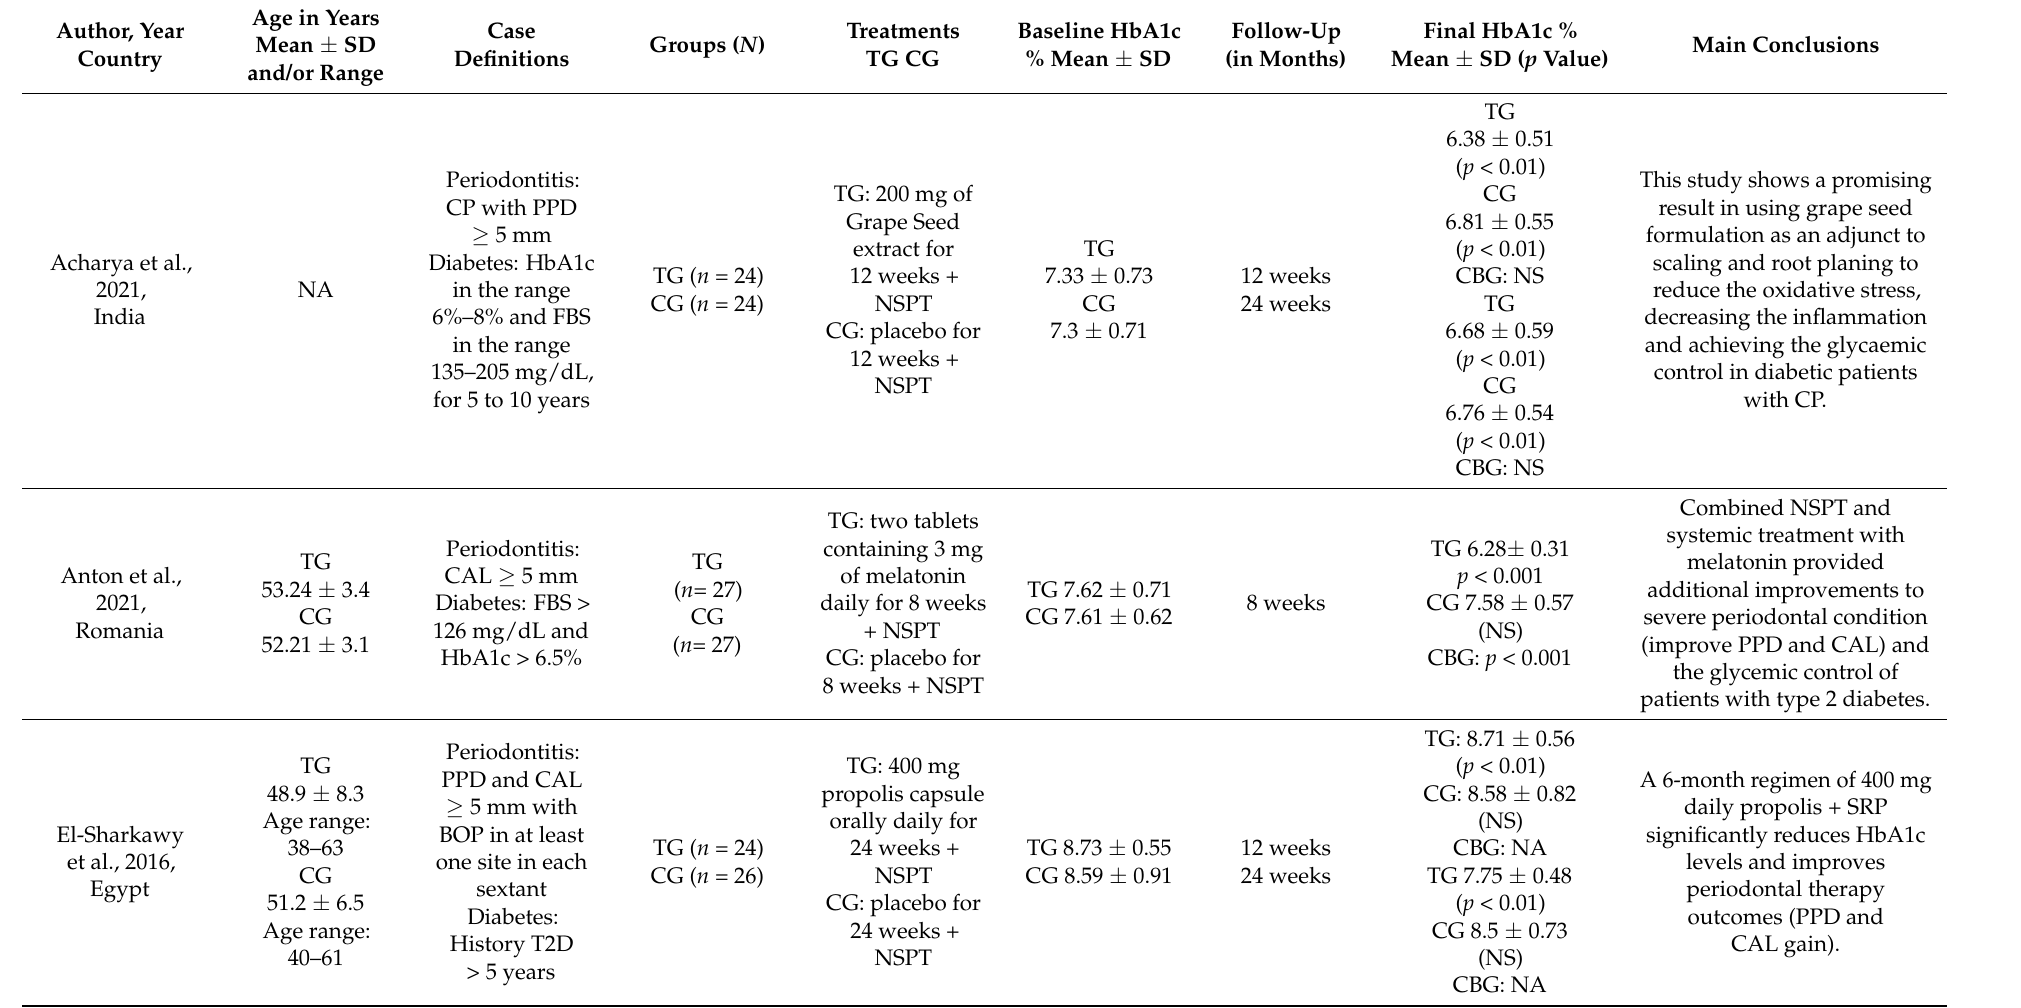
Table 1. Summary of descriptive characteristics of included articles ( n =